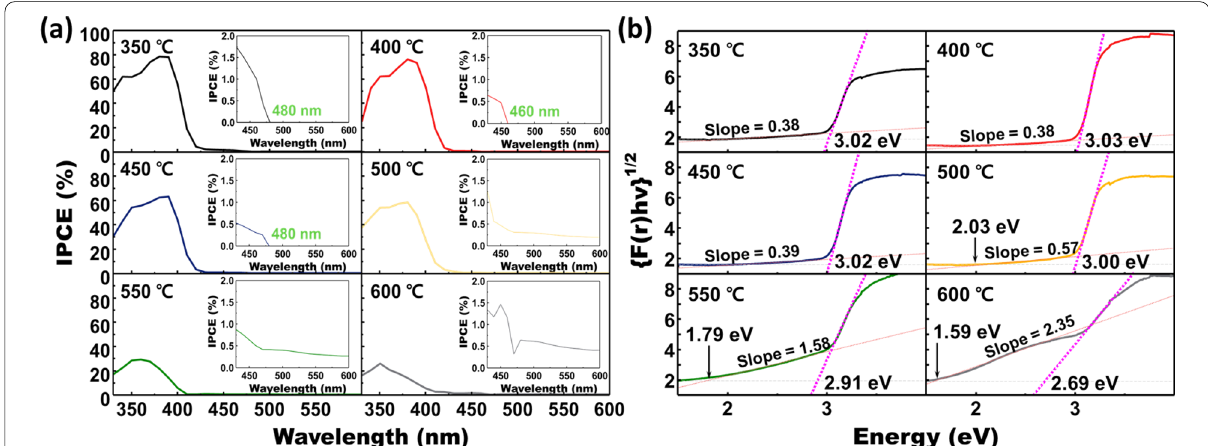
Fig. 4 Bandgap analysis for the 350 °C air-annealed S, N-doped TiO 2 under various H 2 treatment conditions. a The results of IPCE measurement for S, N-doped